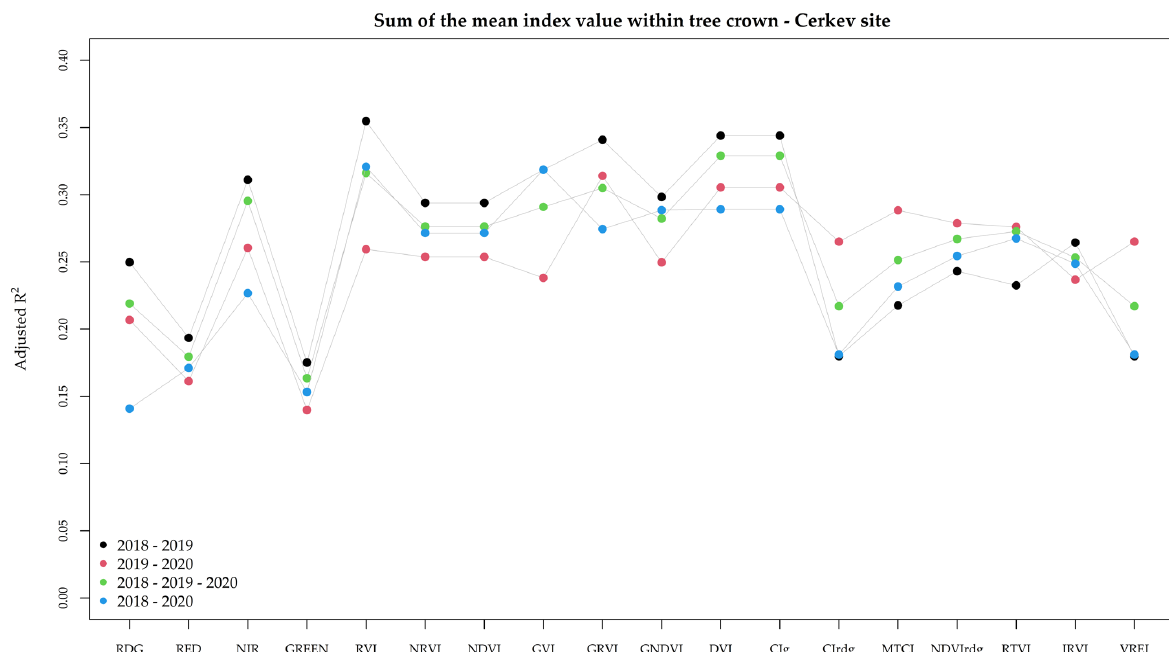
Figure 9. Vegetation index RVI calculated for each tree species and tree group separately (in- jured/uninjured).